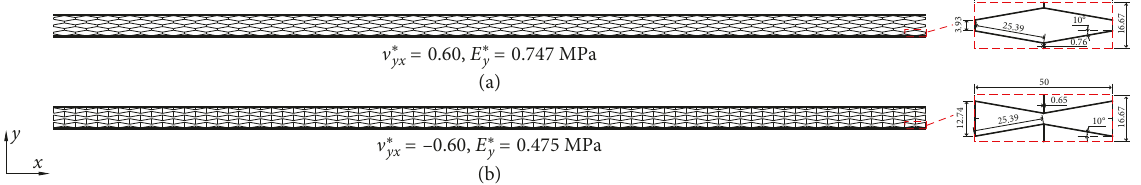
Figure 11: The compared sandwich models with uniform hexagonal honeycomb cores: cell feature angles of (a) 10 ° and (b) − 10 ° .